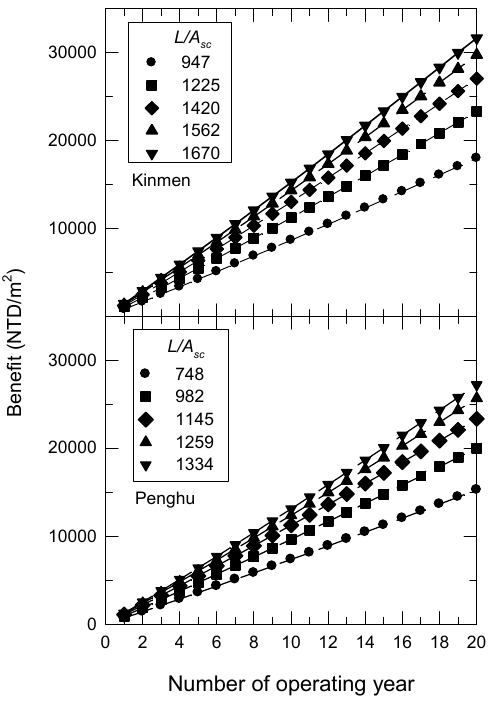
Figure 5. Benefits in terms of reduction in electricity consumption.